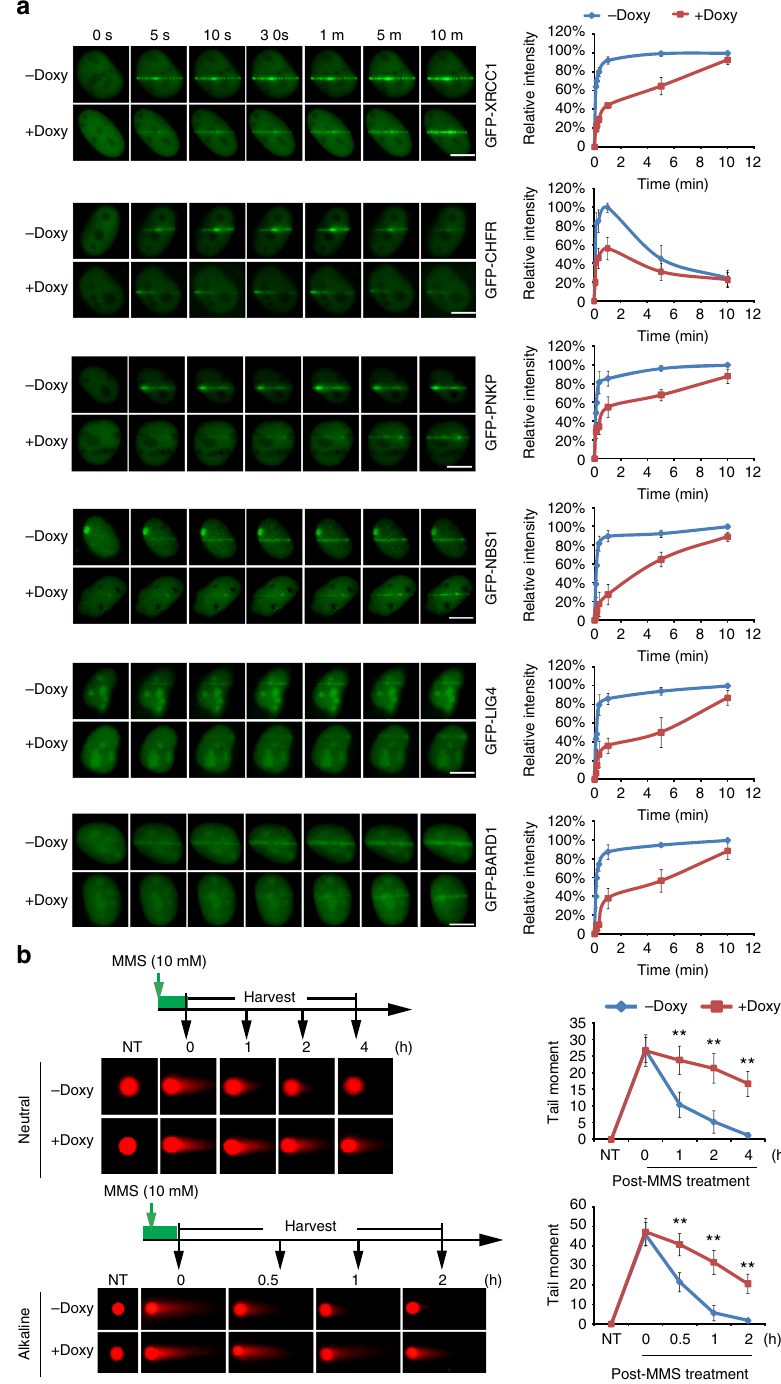
Fig. 5 NADP + suppresses the PARylation-dependent early DNA damage response. a Doxycycline-induced NADK suppresses the recruitment of the PARylation-dependent DNA damage response. Twenty-four hours after induction, the recruitment kinetics of XRCC1, CHFR, PNKP, NBS1, BARD1, and LIG4 were examined with live cell imaging. The relative intensity on the laser stripes were quanti fi ed and summarized at the right panel (mean ± SD, from 15 cells at each time point in each experiment). The highest intensity on the laser stripes was calculated as 100% in each cell, and the kinetics of the recruitment were plotted. Three independent experiments were performed. Bars: 10 μ M. b High level of NADP + impairs DNA damage repair. The cells were treated with methyl methanesulfonate (10 mM, 30 min). The kinetics of double-strand break and single-strand break repair was examined by neutral and alkaline comet assays, respectively. Representative comet tails at different time points are shown. The tail moments were summarized from at least 50 cells at each time point in each experiment, and three independent experiments were performed. NT non-treated. ** p < 0.01. Data were analyzed using